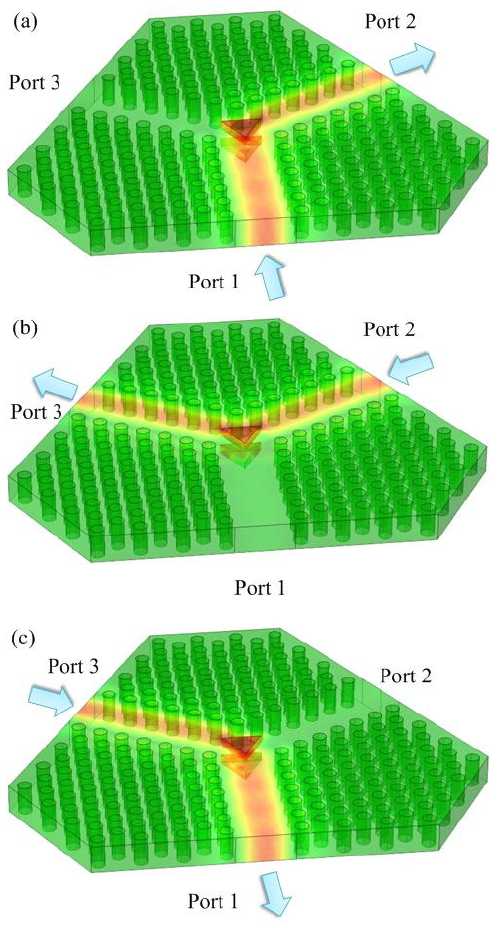
Figure 5. ( a ) The power distribution in the PhC circulator at 26.35 GHz when signal incident from Port 1; ( b ) signal incident from Port 2; ( c ) signal incident from Port 3.